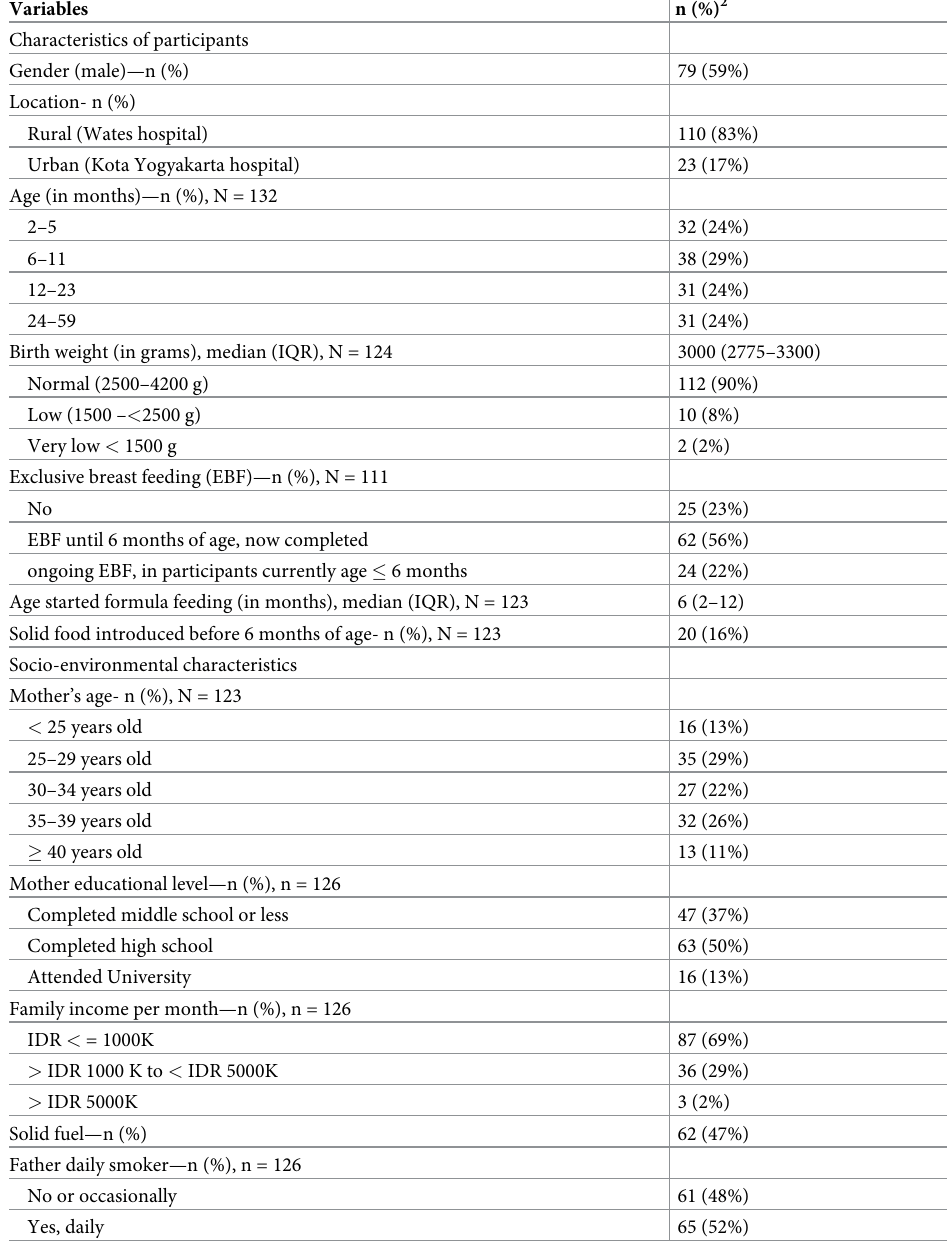
Table 1. Baseline demographics of participants (N = 133) 1